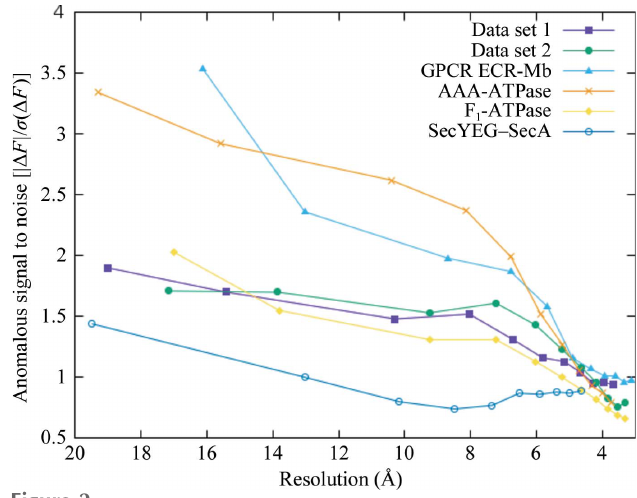
Figure 2 The anomalous signal-to-noise ratio versus resolution for all data sets.